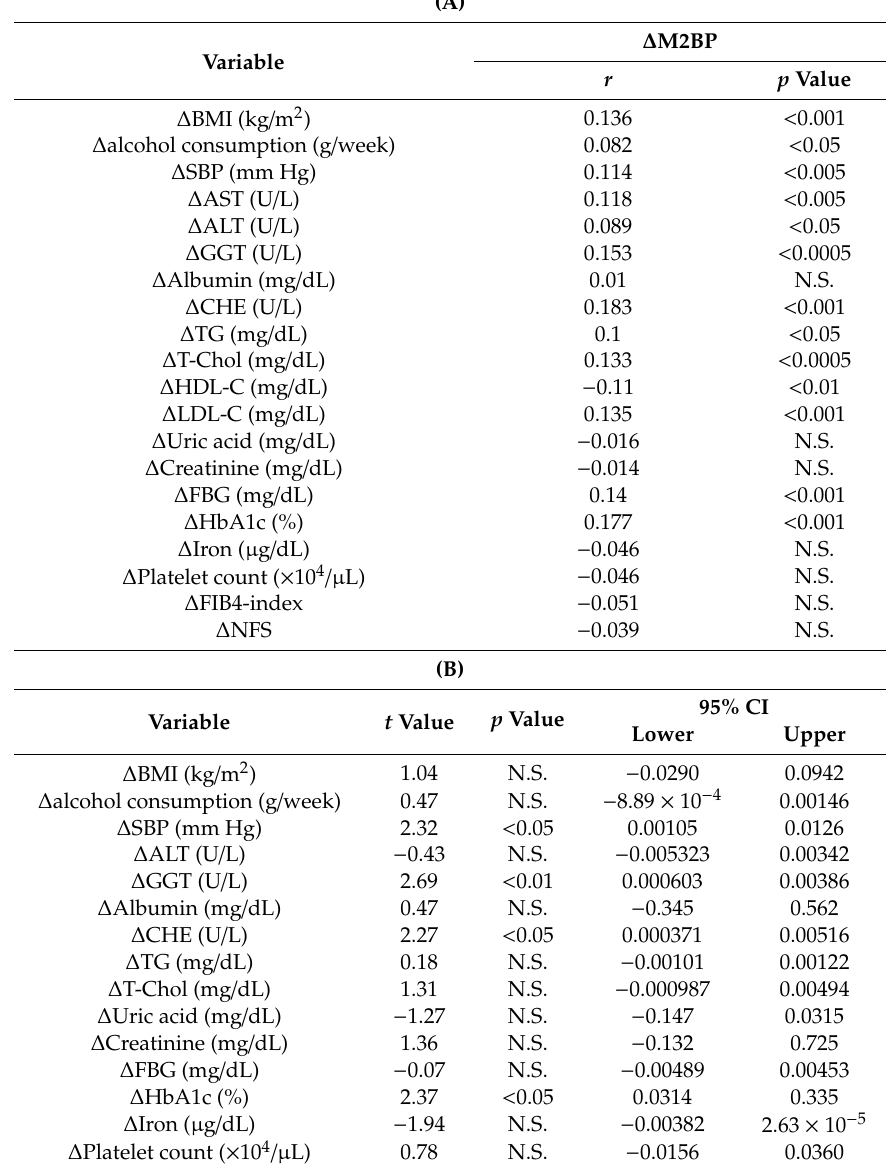
Table 7. Changes in serum M2BP levels were correlated with changes in parameters related